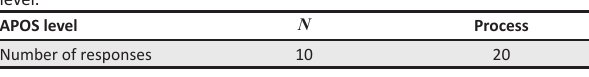
TABLE 5: Frequency of students’ responses for task 1b (ii) according to APOS level.